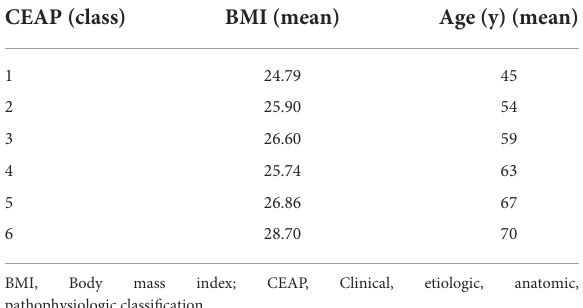
TABLE 2 Correlation between BMI, age, and CEAP class in the study